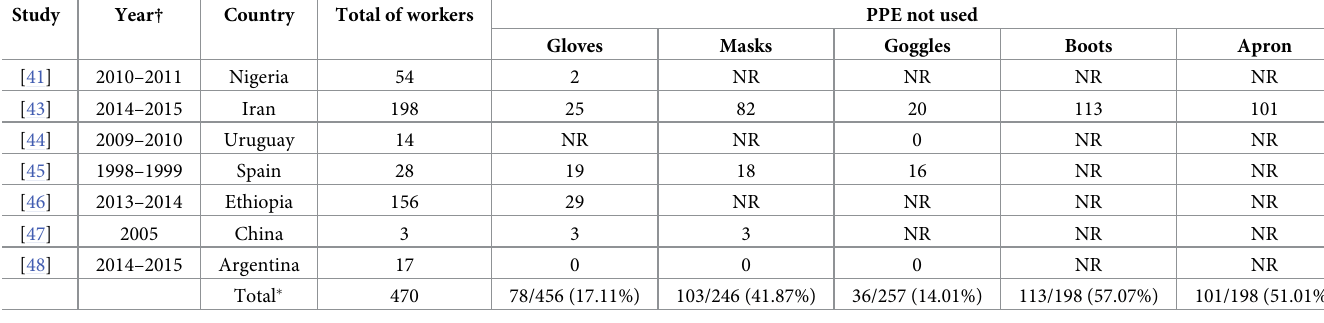
Table 2. Not use of personal protective equipment (PPE) among slaughterhouse workers occupationally infected by Brucella spp. Study